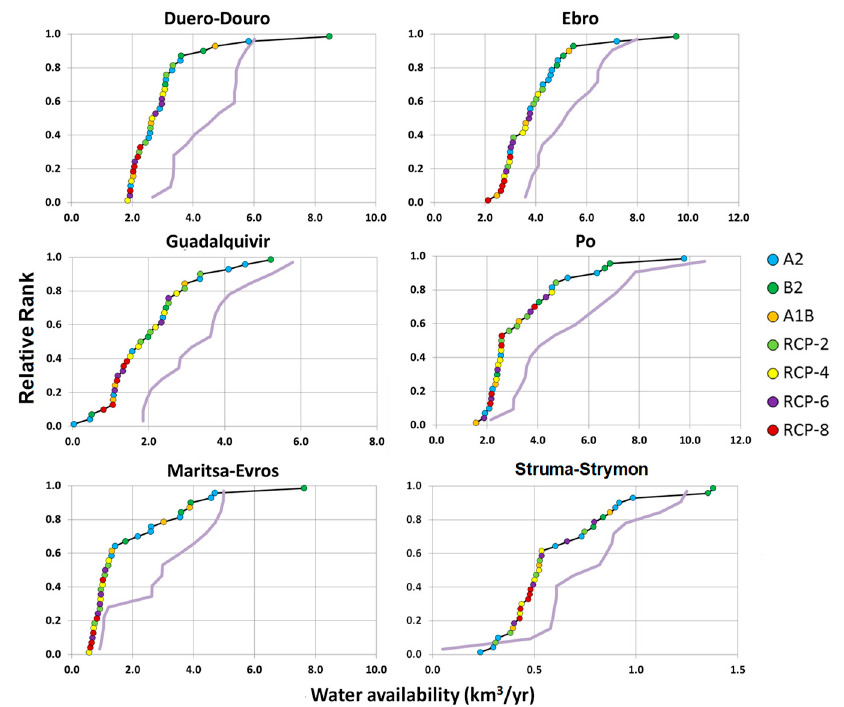
Figure 8. Ranked values of potential water availability (km 3 / yr) in the historical period (purple line) and in the long-term projection (black line) in the basins under study.